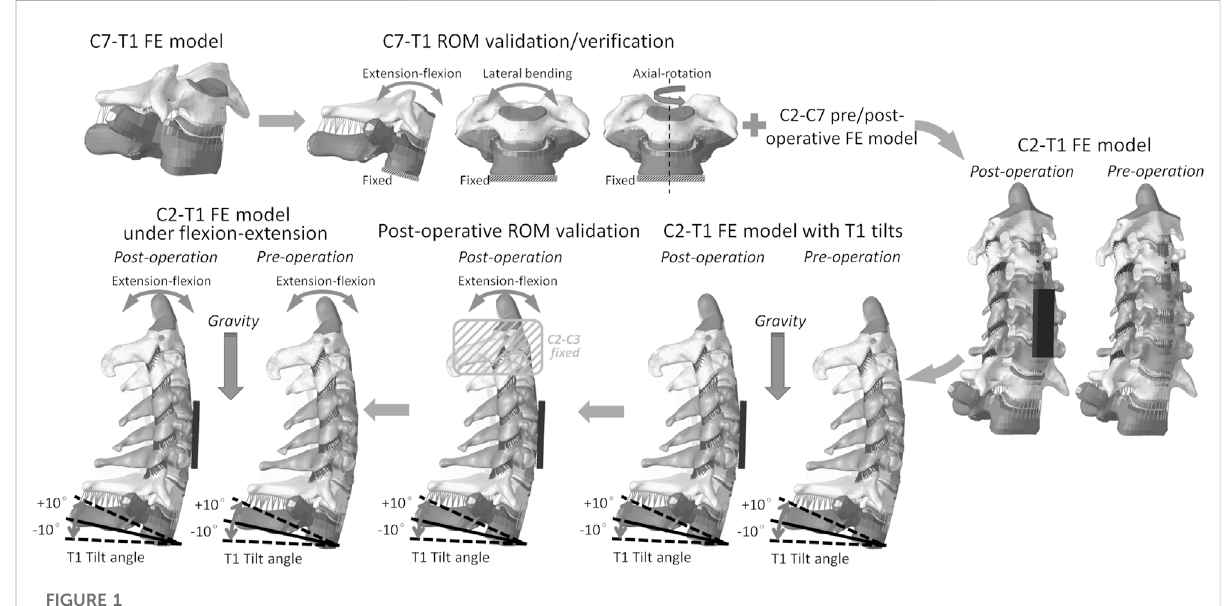
FIGURE 1 C2 – T1 FE model setup work fl ow: C7 – T1 FE model development, C7 – T1 ROM validation and veri fi cation, C2 – T1 FE model integration, C2 – T1 FEmodels of different T1 tilts, C2 – T1 postoperativeROM validation, and C2 – T1 biomechanical response evaluation under fl exion – extension